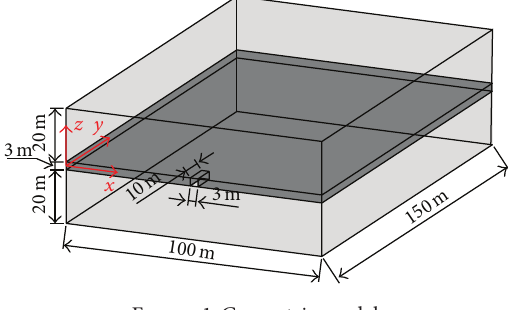
Figure 1: Geometric